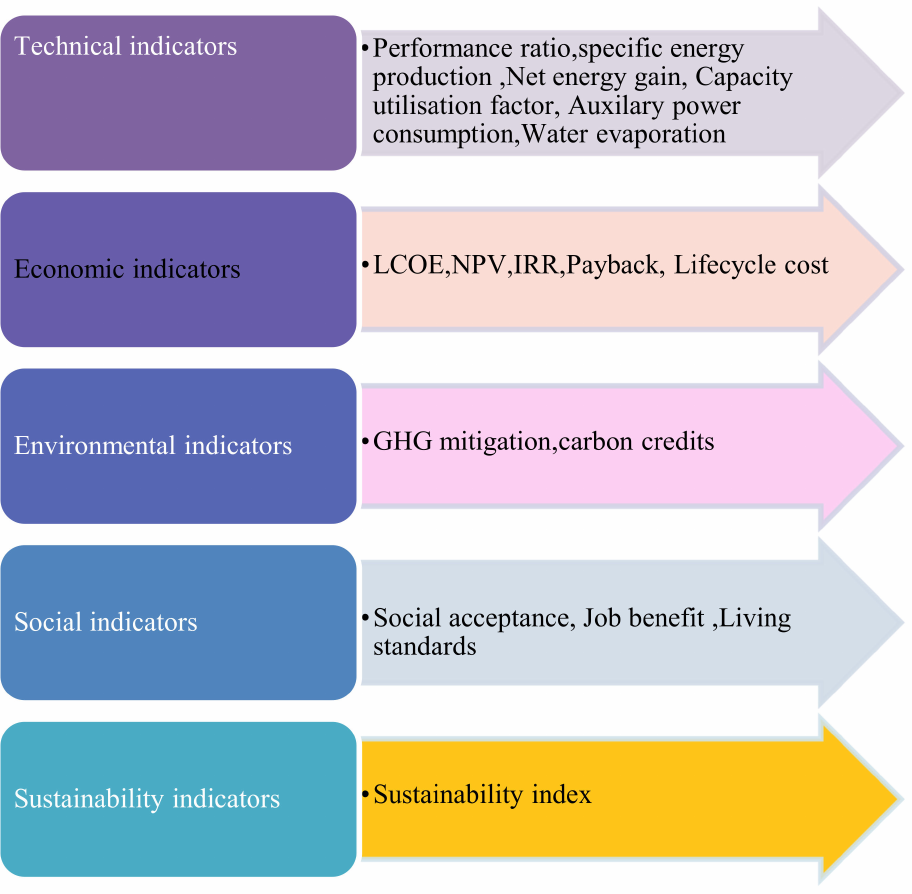
Figure 15. Performance indicators of Hybrid FPV